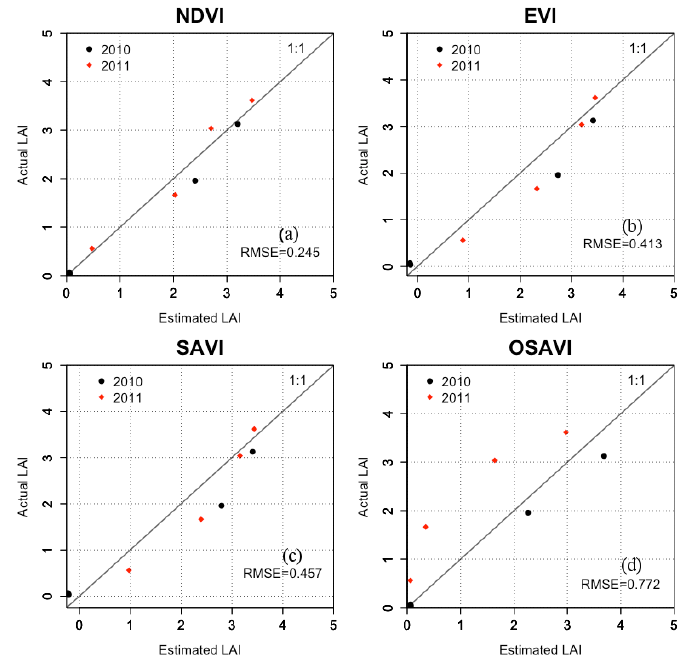
Figure 3. Comparison of results for actual LAI and estimated LAI. ( a ) NDVI; ( b ) EVI; ( c ) SAVI; ( d ) OSAVI; ( e ) MTVI2; ( f ) WDRVI; ( g ) SR; ( h )